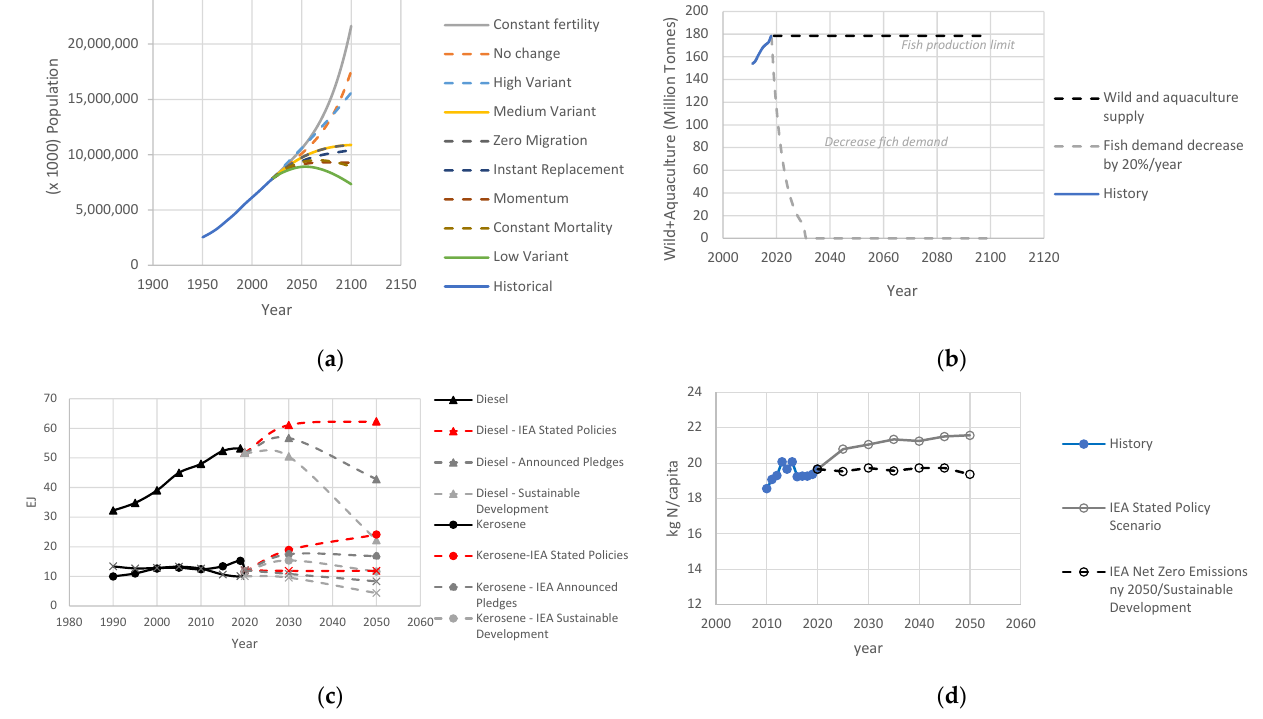
Figure 3. Constraints for future needs, own elaboration: ( a ) history and scenarios for population evolution [22], ( b ) history and scenario for fish oil consumption [23,24] , ( c ) history and scenarios for fossil fuels in transportation [25], ( d ) history and scenarios for N-fertilizer [21].